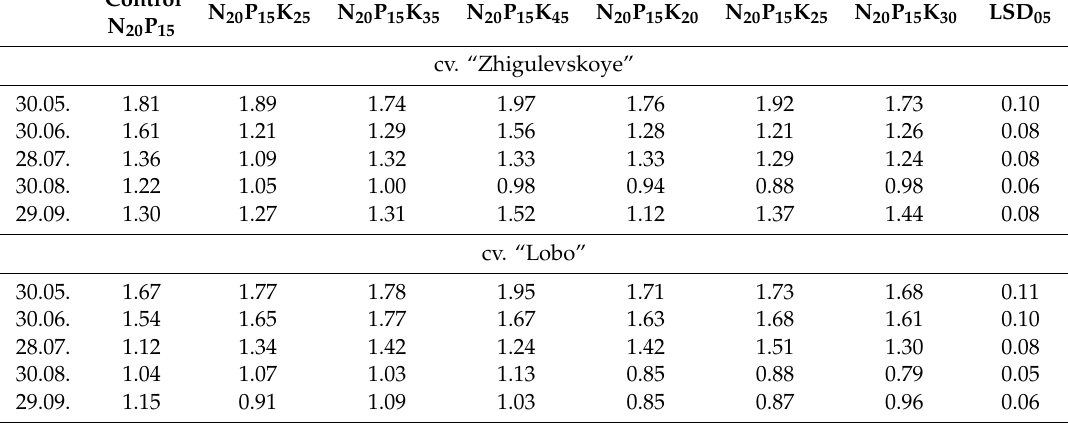
Table 11. Seasonal changes of leaf potassium content under the influence of di ff erent potassium fertilization rates and fertigation approaches in 2016, %